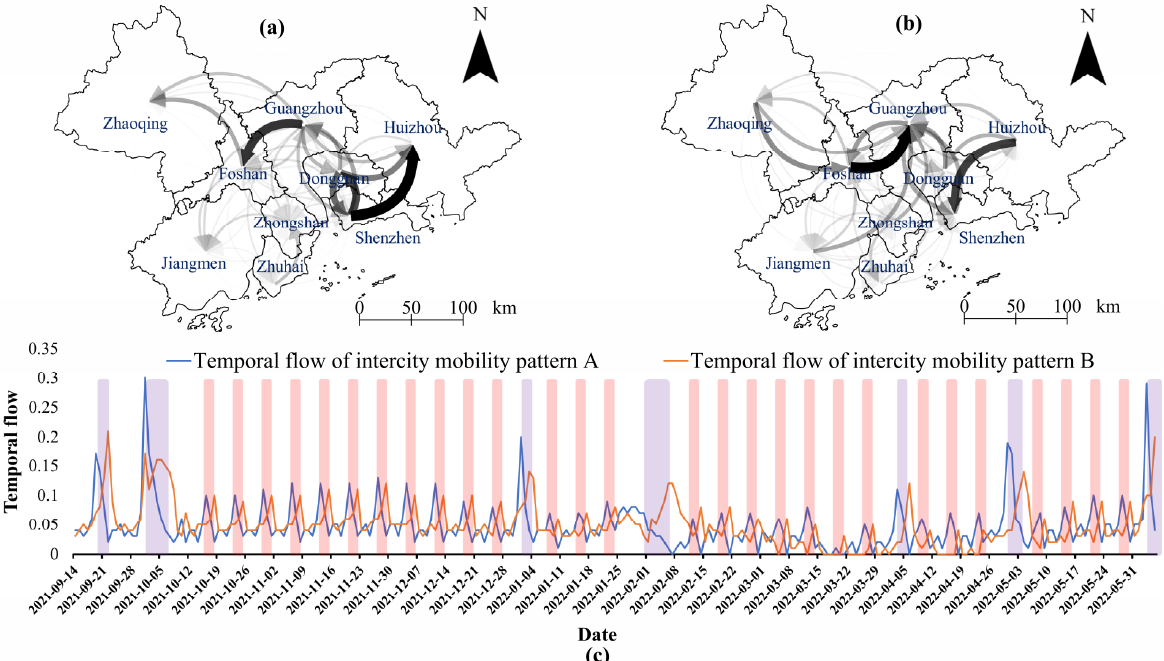
Figure 6. The intercity holiday mobility patterns in the GBA. ( a ) Spatial flow in intercity mobility pattern A. ( b ) Spatial flow in intercity mobility pattern B. ( c ) Temporal flow in intercity mobility patterns A and B. The light red bar denotes the weekend periods, and the light purple bar denotes the holiday periods, respectively.